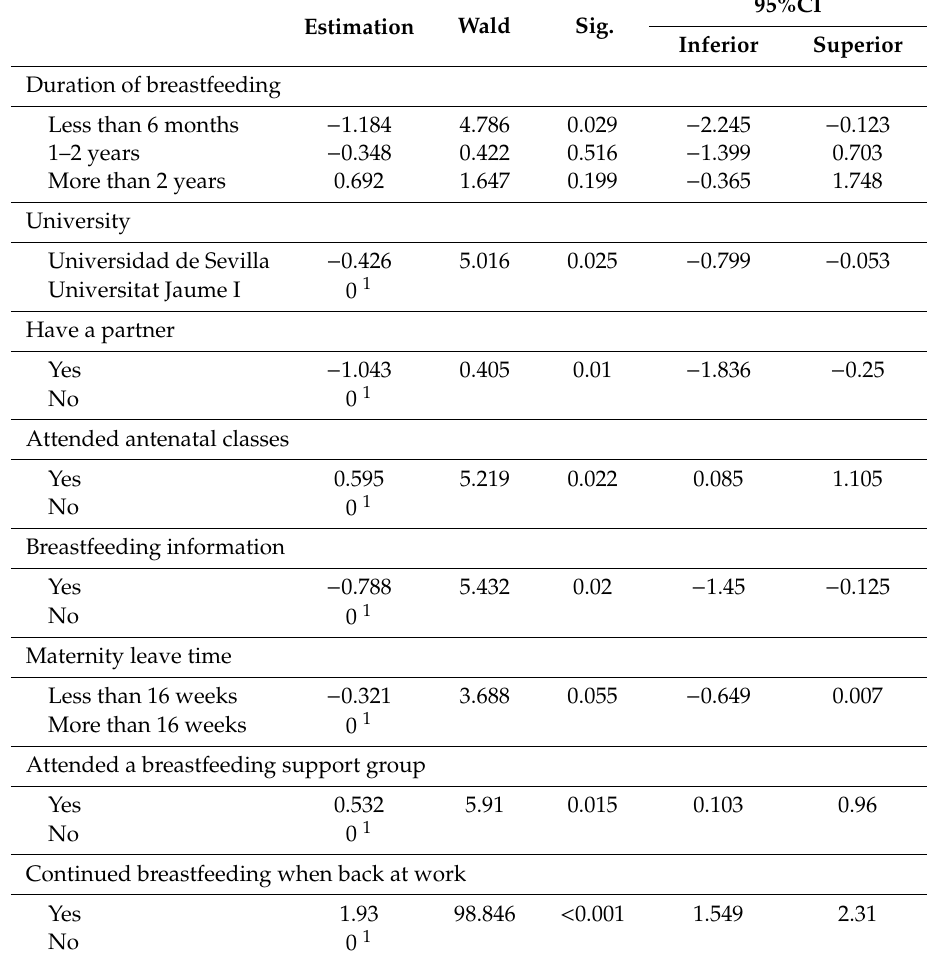
Table 6. Variables that had categories with statistical significance and were included in the later logistic regressions. Estimation Wald Sig.